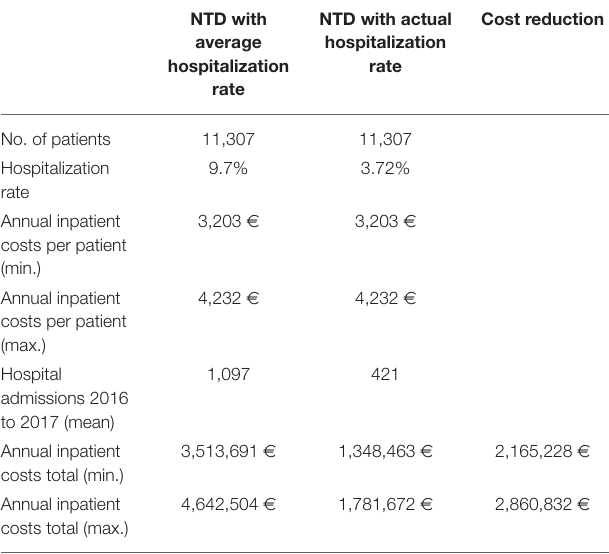
TABLE 6 | Calculation of healthcare cost